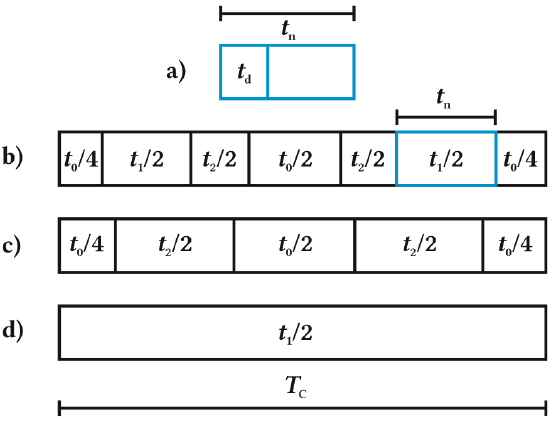
Figure 7. Voltage vector switching sequence within a T C sampling period.